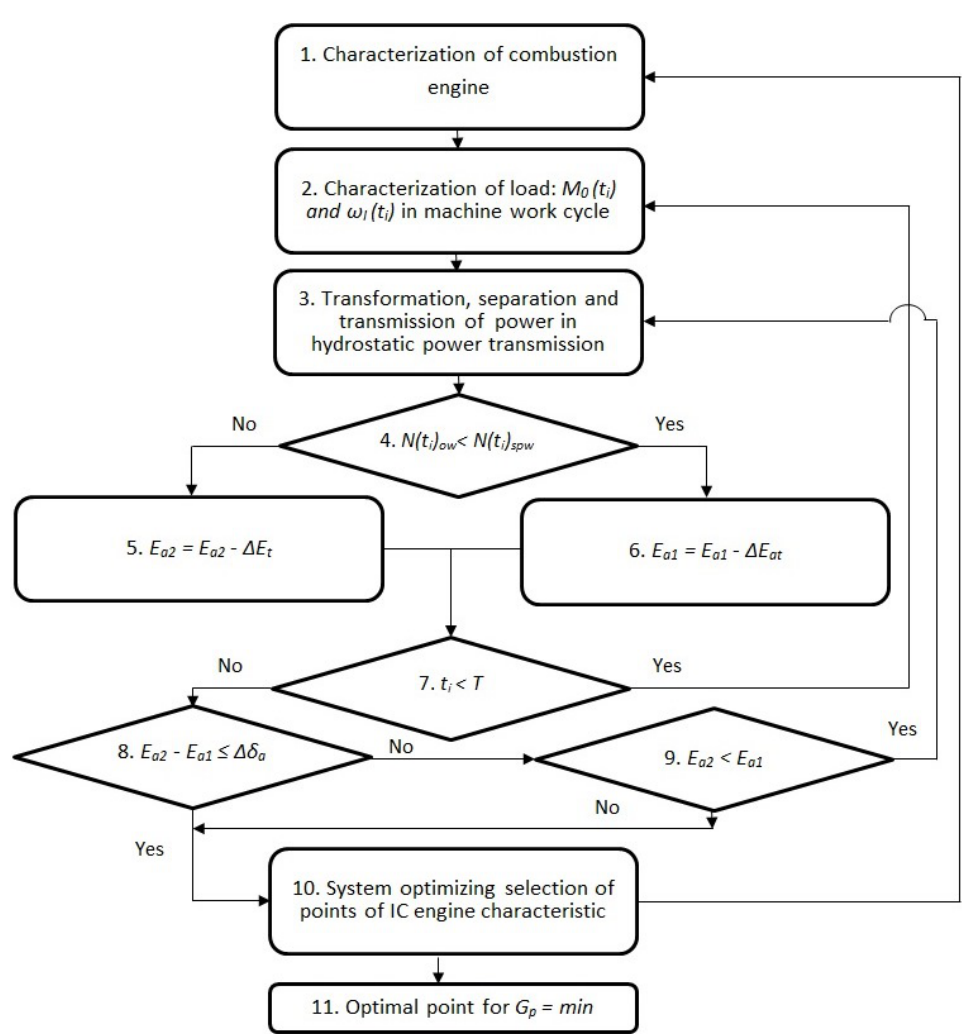
Figure 6. Process algorithm (kinetostatic method) block diagram ( M : torque; ω : angular velocity; T : time of cycle; E : energy; E a 1 : energy supplied to the accumulator; E a 2 : energy taken from the accumulator; ∆ E t : losses in the hydraulic unit; ∆ E at : energy losses in the accumulation unit; ∆ δ a : accumulator energy balance (usually less than 1%); G p : quality criteria; t : time; indexes: 0: load; i : iteration)